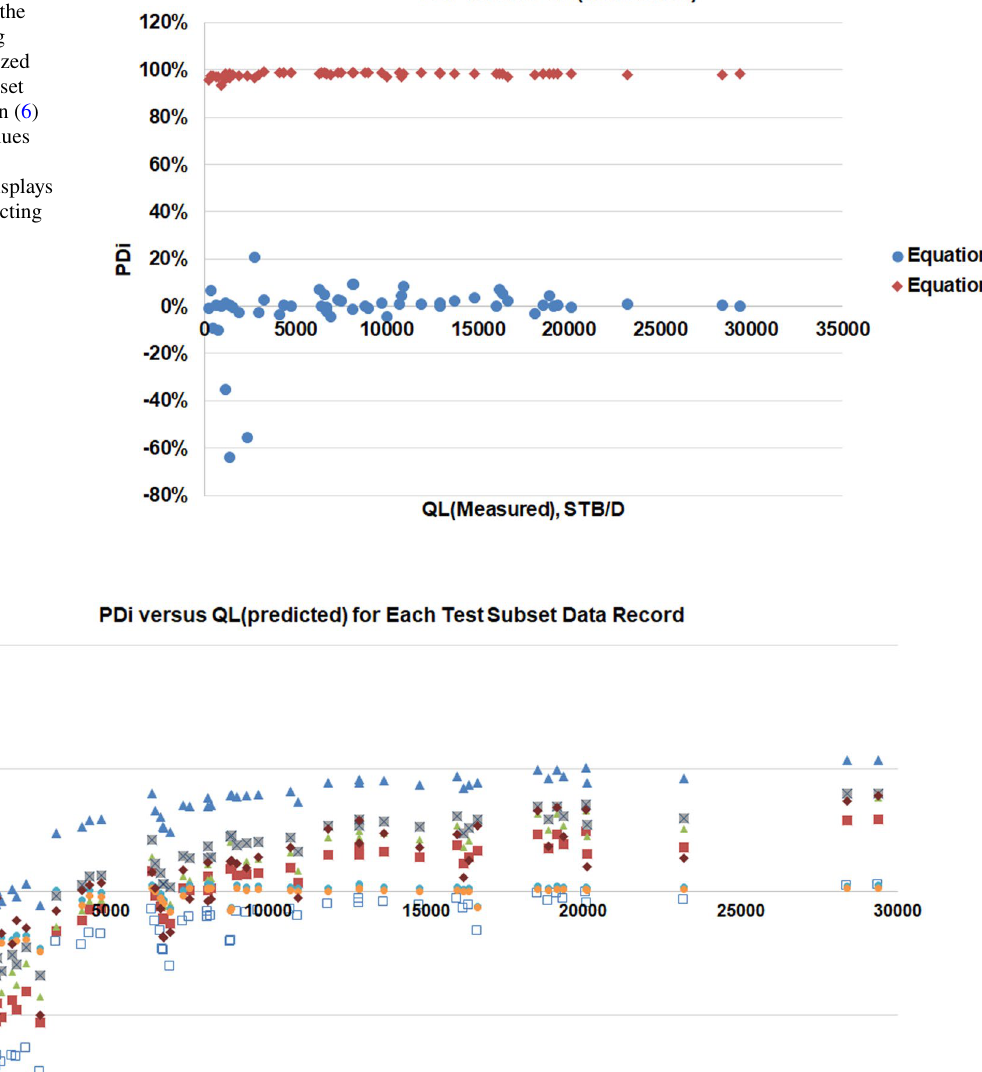
Fig. 9 Percent deviation (PD calculated by Eq. (11) for the Reshadat oil field applying Eq. (6) and the GA optimized Eq. (8) to the test data subset (55 data records). Equation (6) displays very high PDi values (reflecting high prediction errors), whereas Eq. (8) displays